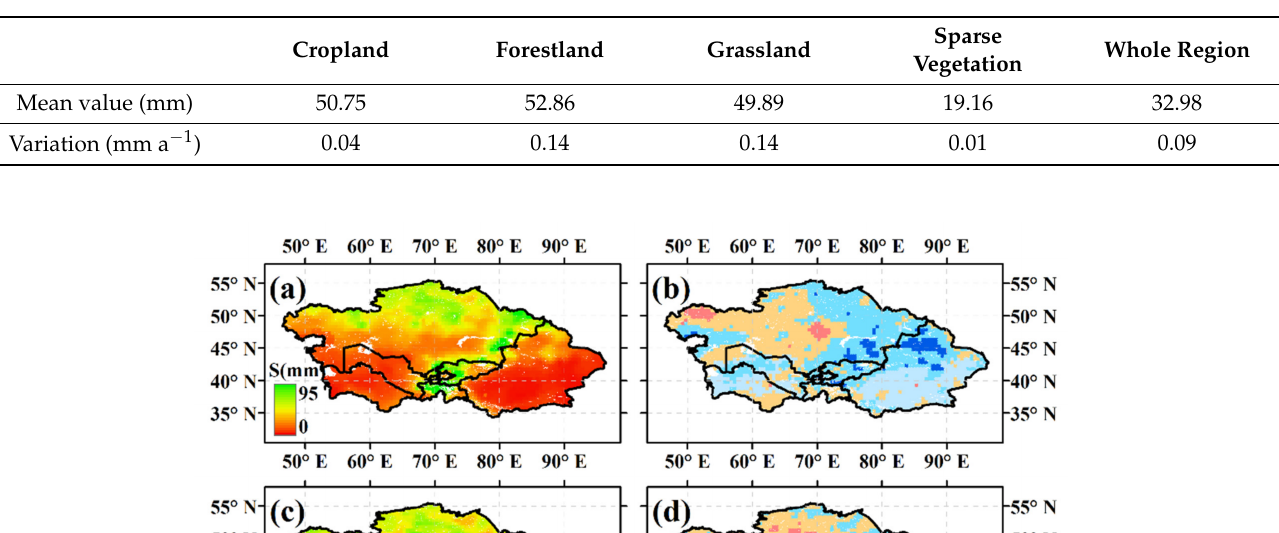
Table 2. Winter snowfall and its variation for each land-cover type and the whole region in 1982–2015.